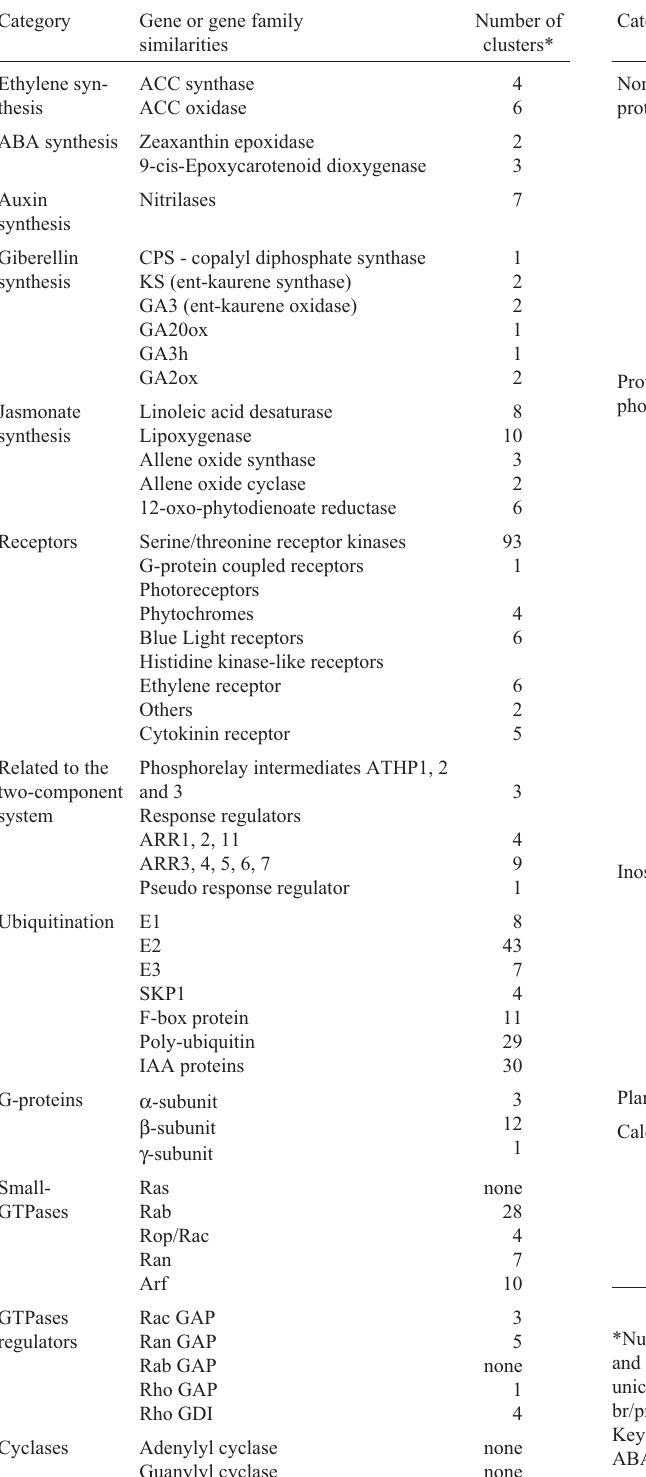
Table I - Catalogued sugarcane signal transduction